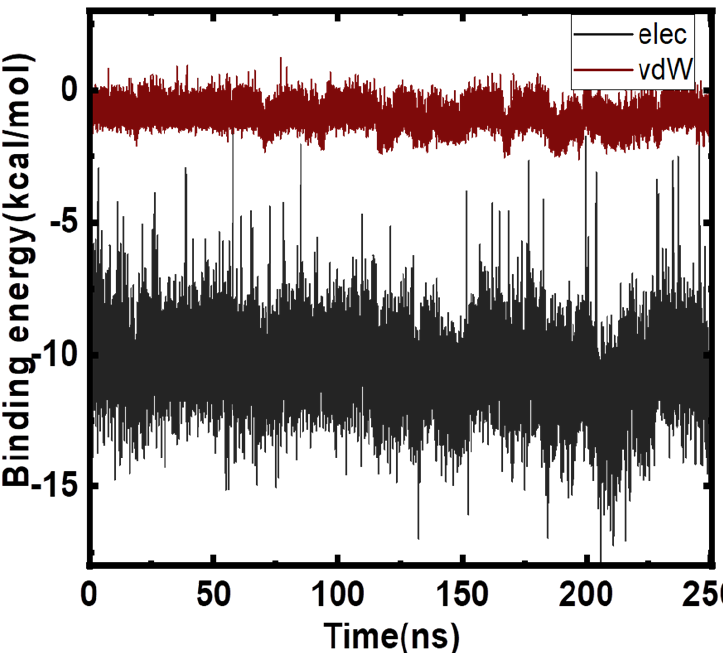
Figure 6. LIE energies plotted as a function of snapshots. Table 1. MMGBSA free energy estimate for Mtf